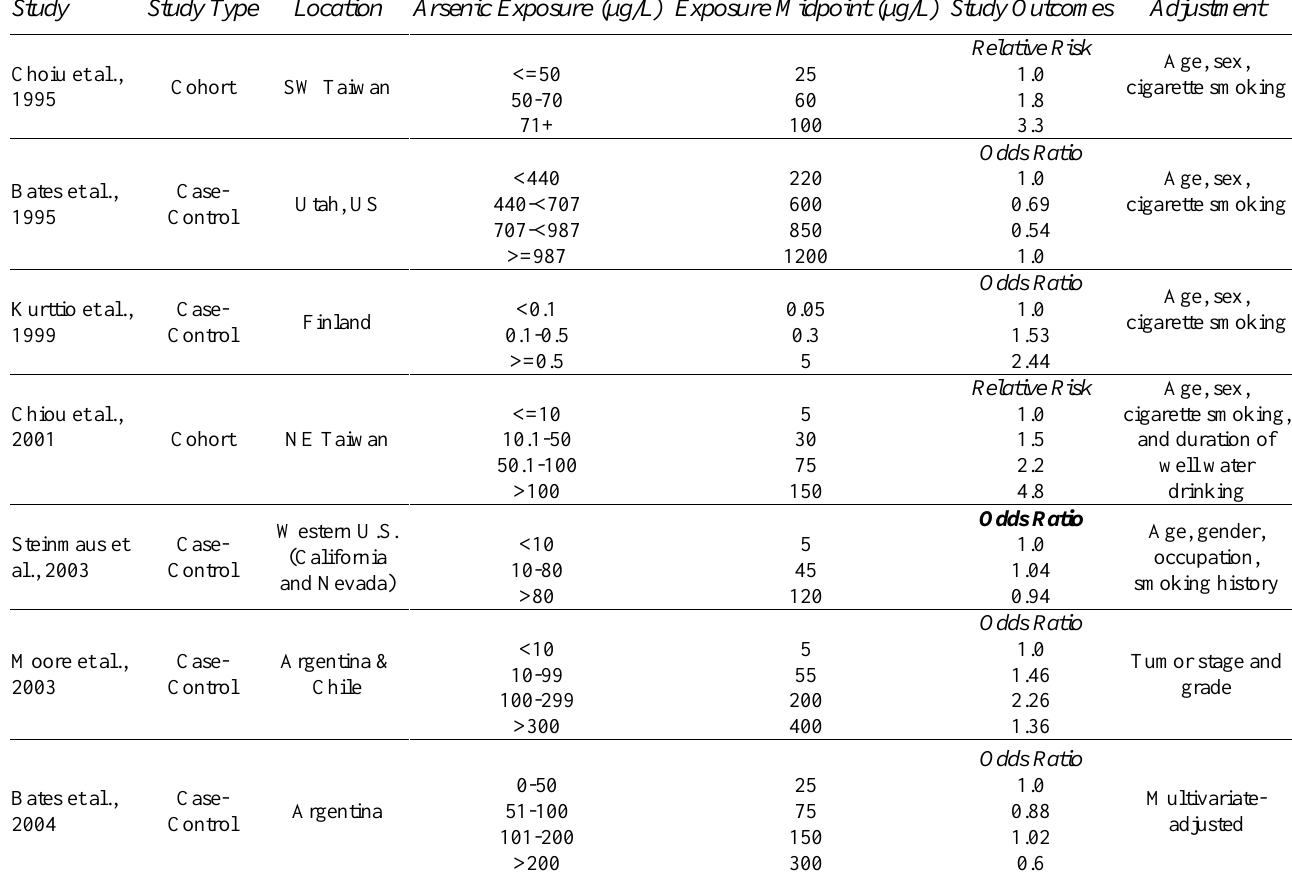
Table 1: Studies of Bladder Cancer (188)